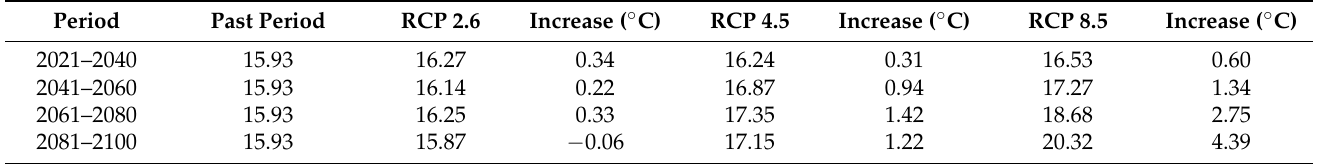
Table 4. Change in average interannual temperature in ◦